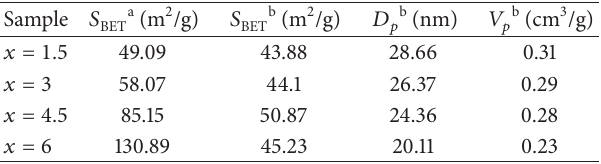
LDH (a) and LDO 2